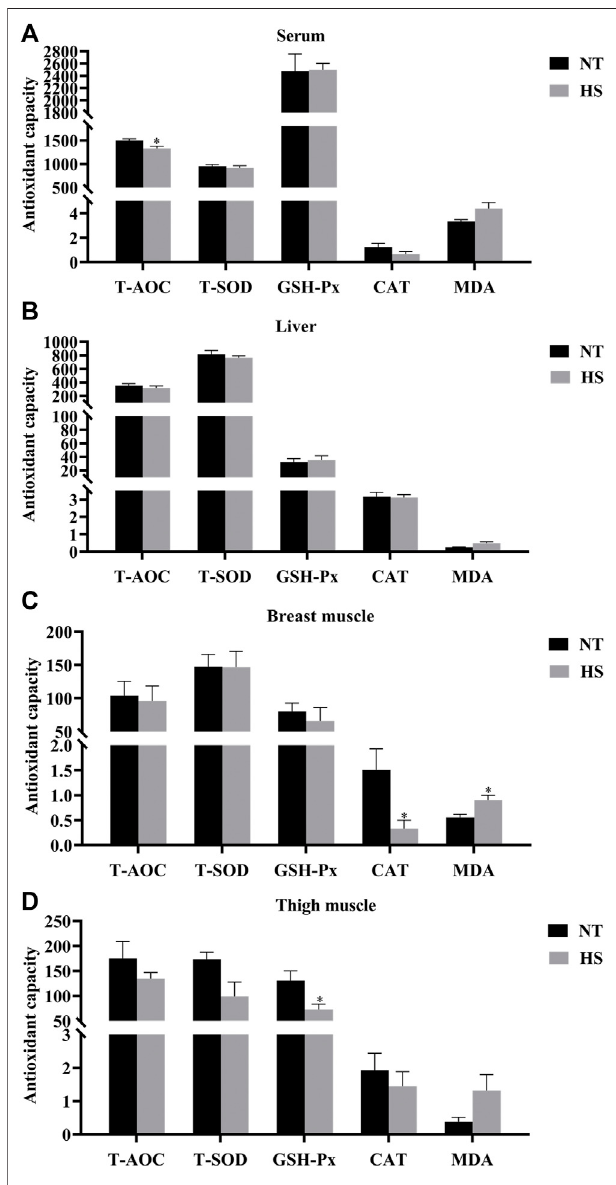
FIGURE 1 | Effects of heat stress on antioxidant capacity of serum (A) , liver (B) , breast muscle (C) , and thigh muscle (D) in indigenous broilers (n = 5/ group). T-AOC, total antioxidant capacity. T-SOD, total superoxide dismutase. GSH-Px, glutathione peroxidase. CAT, catalase.